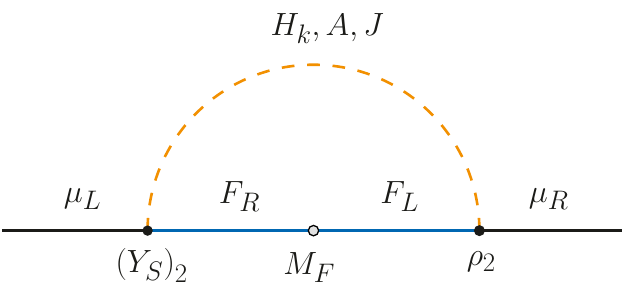
Figure 1 . Dominant new physics contribution to the muon anomalous magnetic